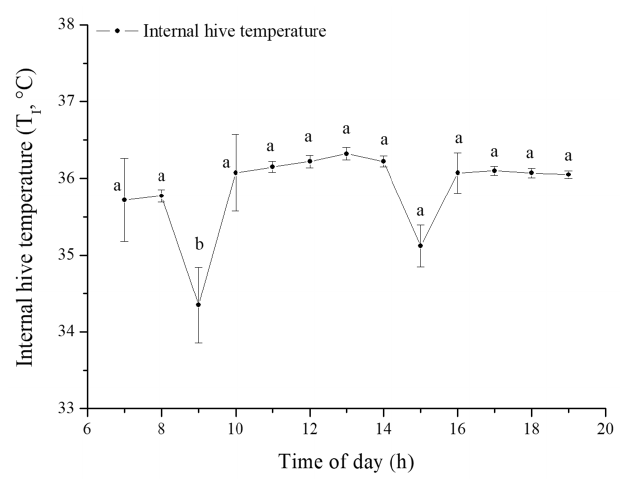
Fig 2 . Temporal variation of the internal temperature (T beehives submitted to a 33 °C thermal controlled environment. Different letters indicate a significant difference (Tukey test, p < 0.05).